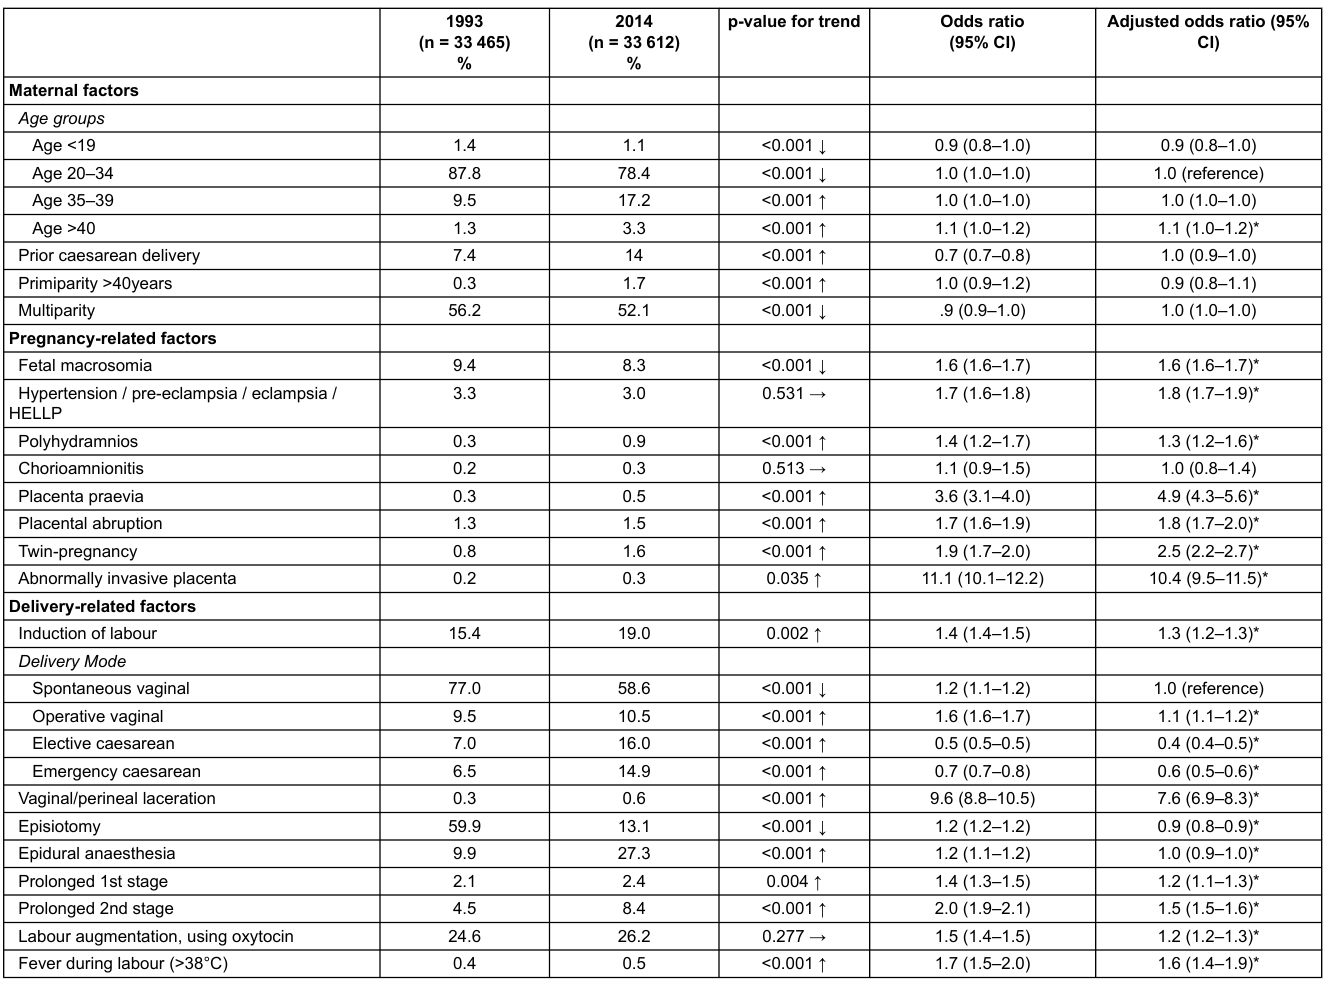
CI = Confidence interval Table shows incidences of risk factors and their trend statistics and unadjusted and adjusted odds ratios for postpartum haemorrhage controlling for maternal, pregnancy-related, and delivery-related factors. Arrows indicate direction of trend (↑ rising, ↓ falling, → indifferent). * indicates a statistically significant difference (p <0.05) from the reference